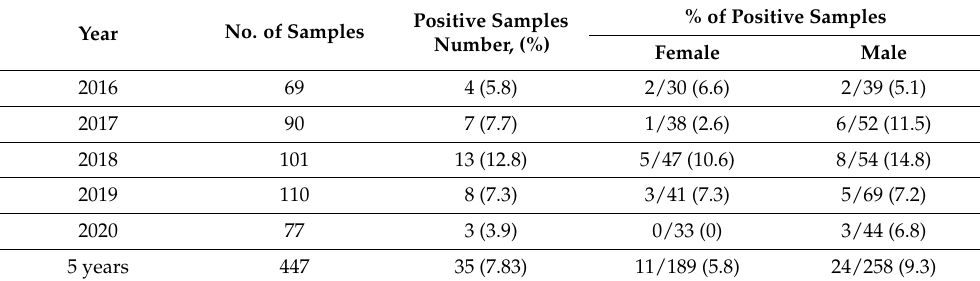
Table 1. Incidence of HAdV in children with acute diarrhea in Cairo, Egypt from 2016 to 2020.